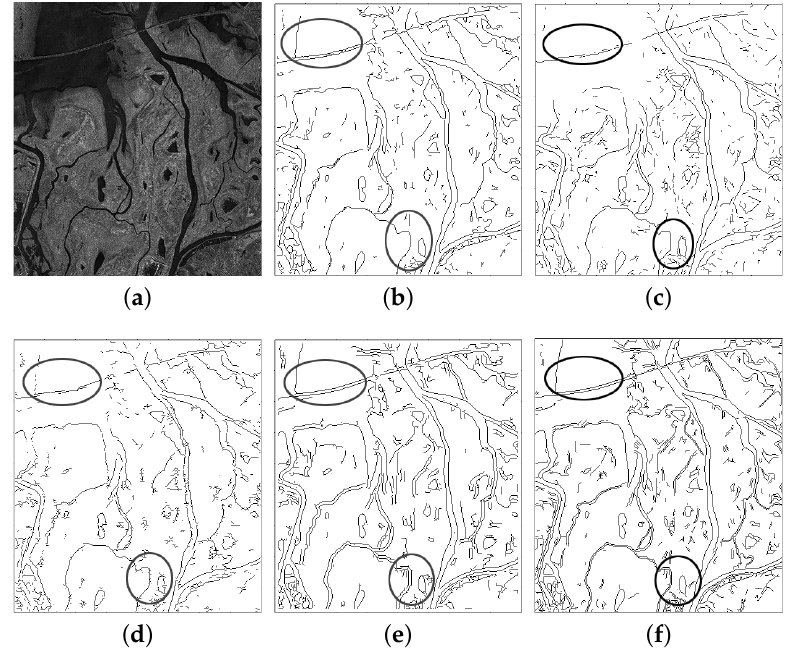
Figure 17. Results on the second satellite SAR image. ( a ) The raw image; ( b ) SAR-PC; ( c ) PC; ( d ) Log-PC; ( e ) RBED; ( f )